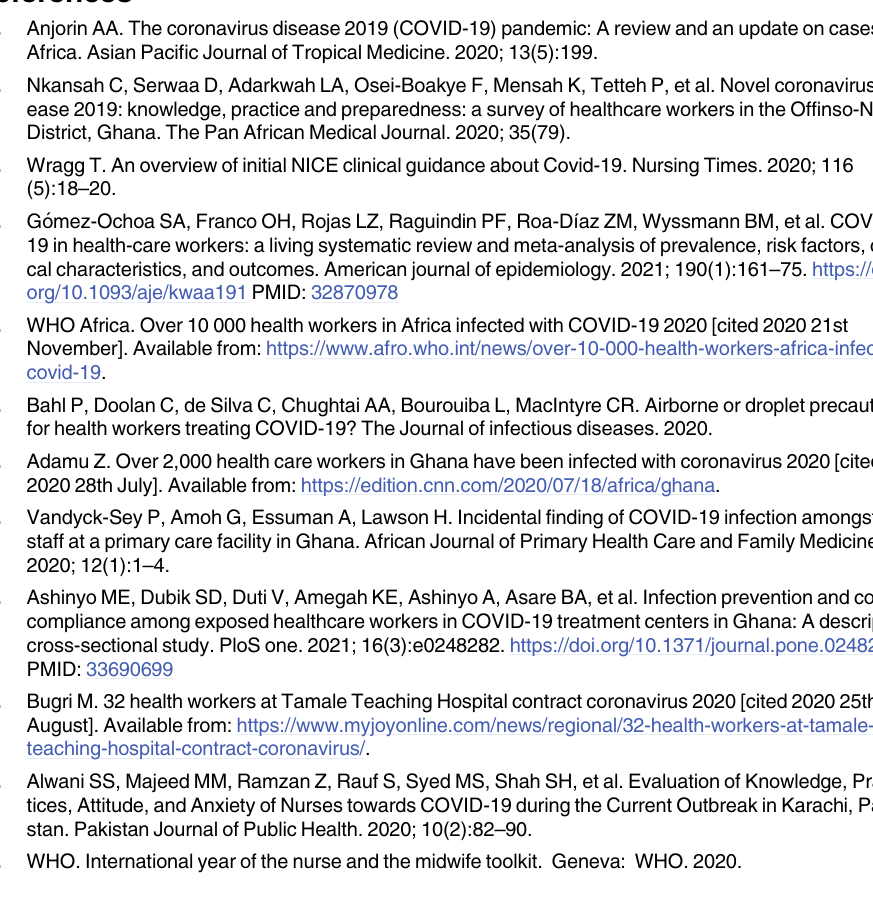
S2 Table. Nurses’ knowledge of COVID-19 features and its preventive measures at health facilities in Tamale, Ghana (n = 339). S3 Table. Nurses ’ adherence to COVID-19 safety protocols at health facilities in Tamale, Ghana (n =